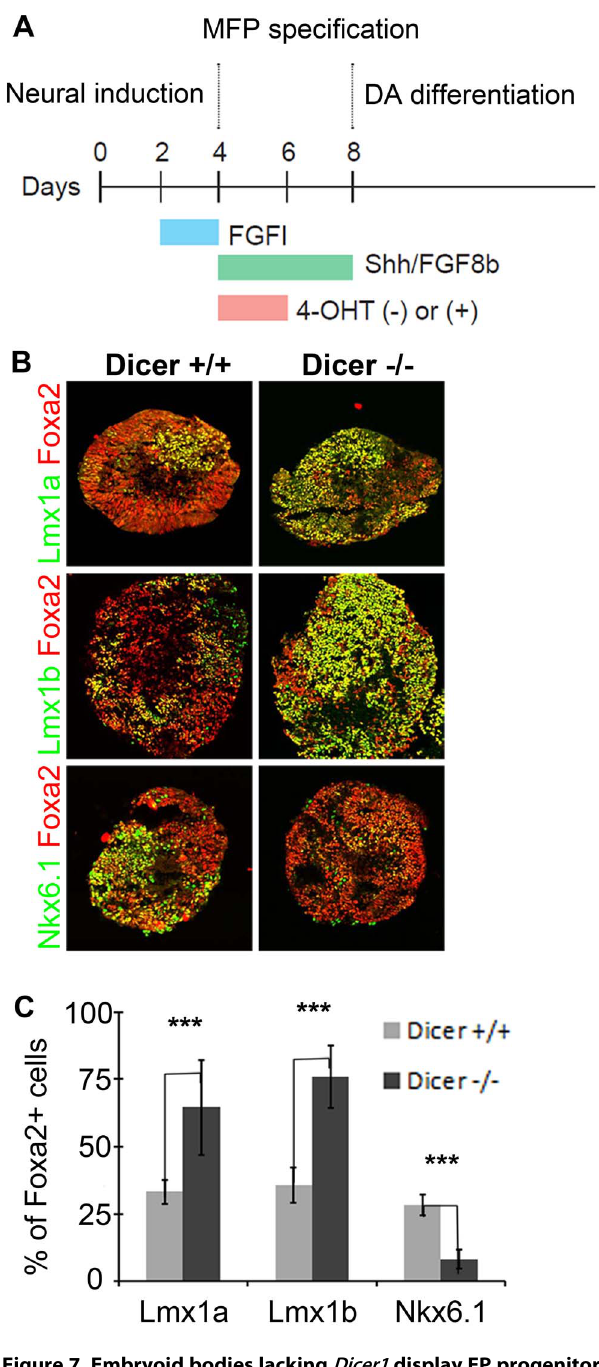
Figure 7. Embryoid bodies lacking Dicer1 display FP progenitor allocation changes. (A) Protocol used for mDA differentiation from embryoid body aggregates and conditional removal of Dicer1 . (B) In the absence of Dicer1 , Lmx1a/b + mDA progenitors are increased at the expense of Nkx6.1 + progenitors. (C) Unbiased Metamorph analysis to quantify marker expression in Foxa2 + progenitors (n=15 embryoid bodies; Lmx1a control mean = 33.19 6 4.49, Lmx1a mutant mean = 64.55 6 17.46; Lmx1a p-value = 4.94E-09/Lmx1b control mean=35.71 6 6.61, Lmx1b mutant mean=75.94 6 11.65; Lmx1b p- value=1.55E-10/Nkx6.1 control mean=28.32 6 3.73, Nkx6.1 mutant mean=8.28 6 3.36; Nkx6.1 p-value=2.02E-10).